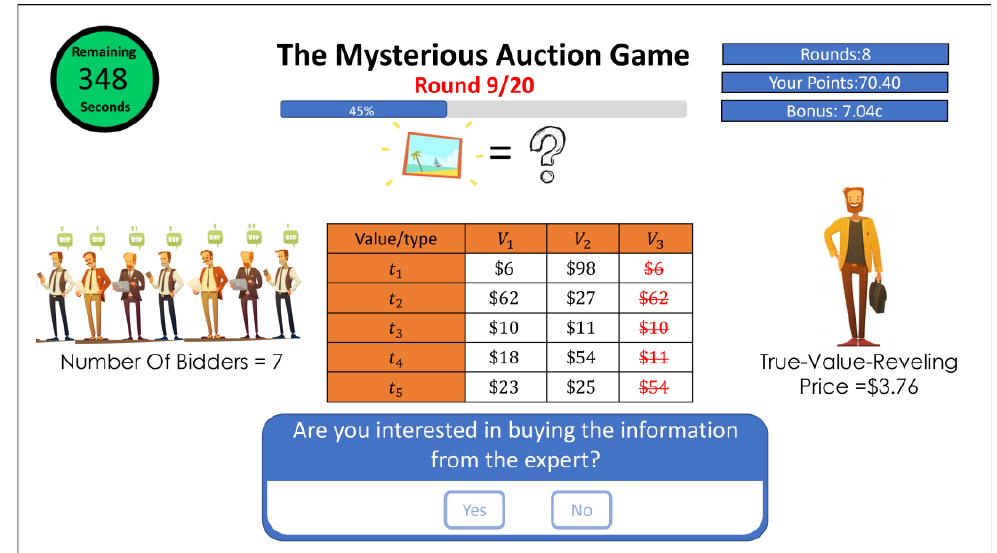
Figure 3. An example for how signals are being represented in The Mysterious Auction Game.